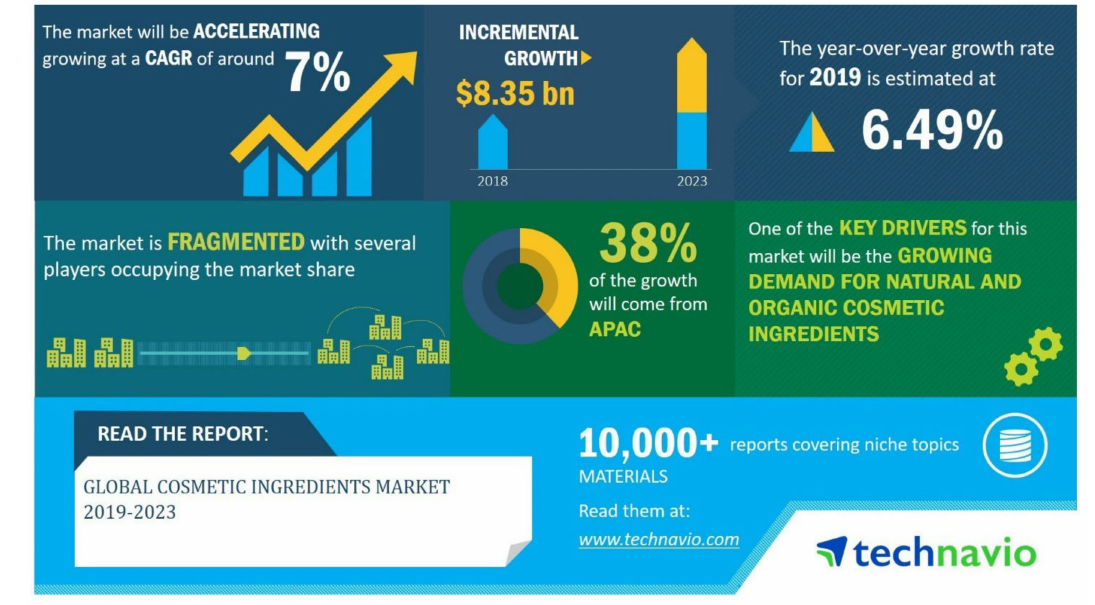
Figure 13. Global Cosmetic Ingredients market, driven by natural-oriented compounds (by the courtesy of Technavio).